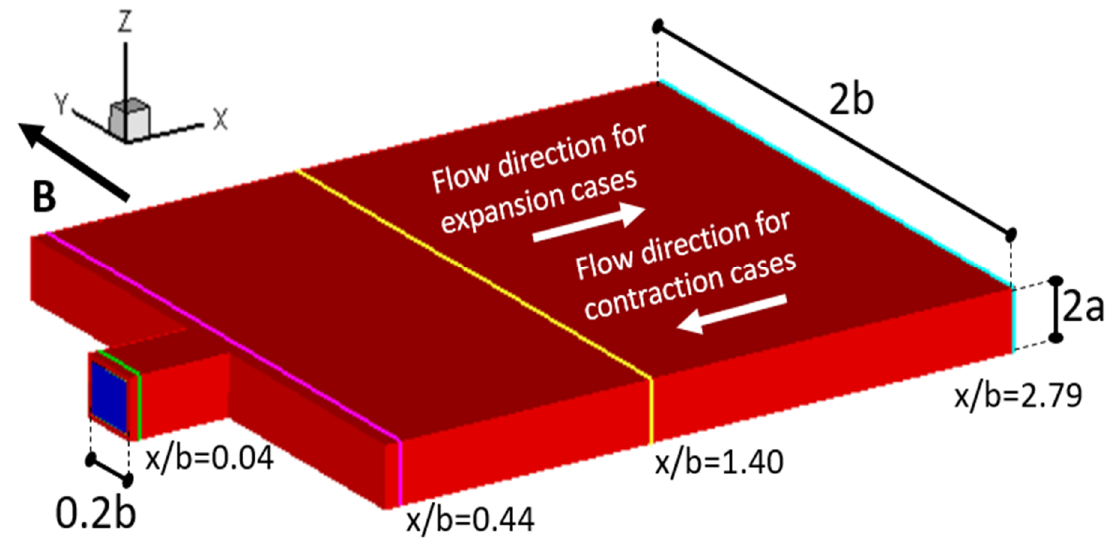
Figure 19. The simulation geometry is a duct with a sudden expansion or contraction depending on the flow direction. The flow in the inlet manifold features expansion (the flow direction is from left to right), while the flow in the outlet manifold (the flow direction is from right to left) experiences contraction.